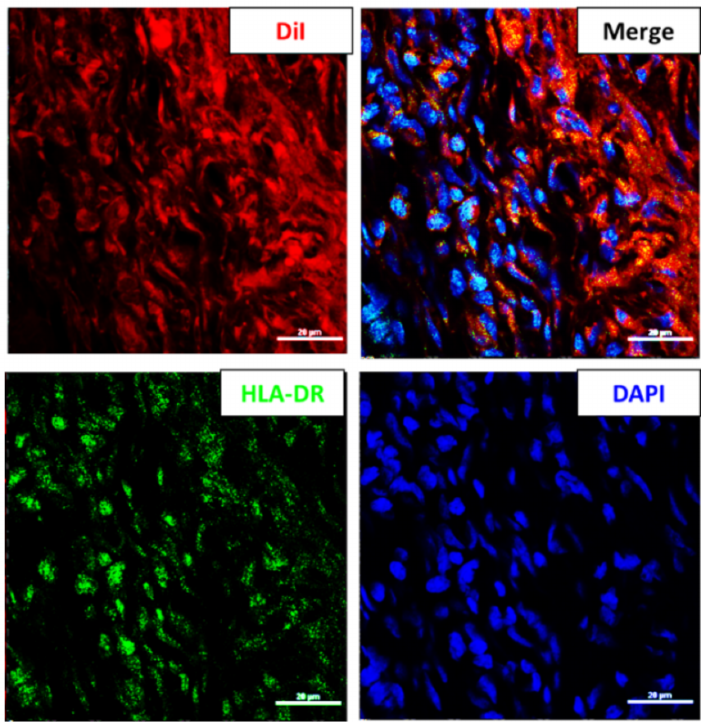
Figure 5. The HLA-DR positive hWJMSC in the vitreous cavity four weeks after transplantation. Representative image of HLA-DR staining in the vitreous cavity. The HLA-DR-positive cells and the nuclei were labeled in green and blue colors, respectively. DiI was used to label the transplanted hWJMSC in red color. Scale bar: 20 µ m. DAPI, 4, 6-diamidino-2-